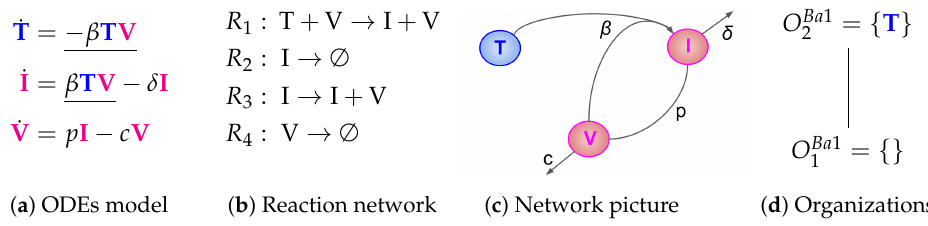
Figure 2. The Baccam Model [13] with three variables: uninfected (susceptible) target cells ( T ), infected cells ( I ) and infectious-viral titer ( V